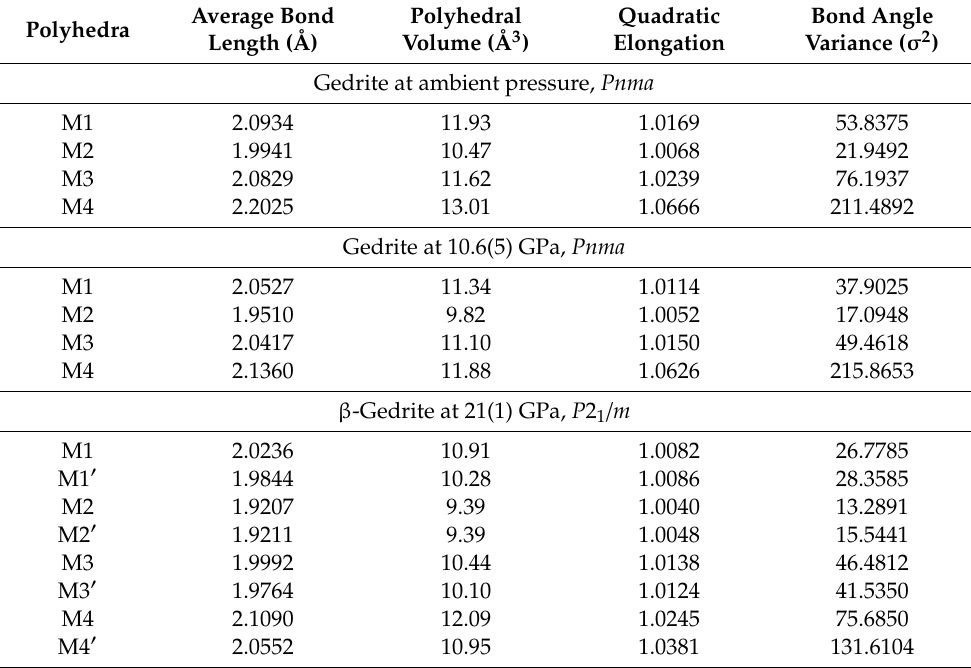
Table 4. Polyhedra volumes and distortion parameters of gedrite at various pressures and 298